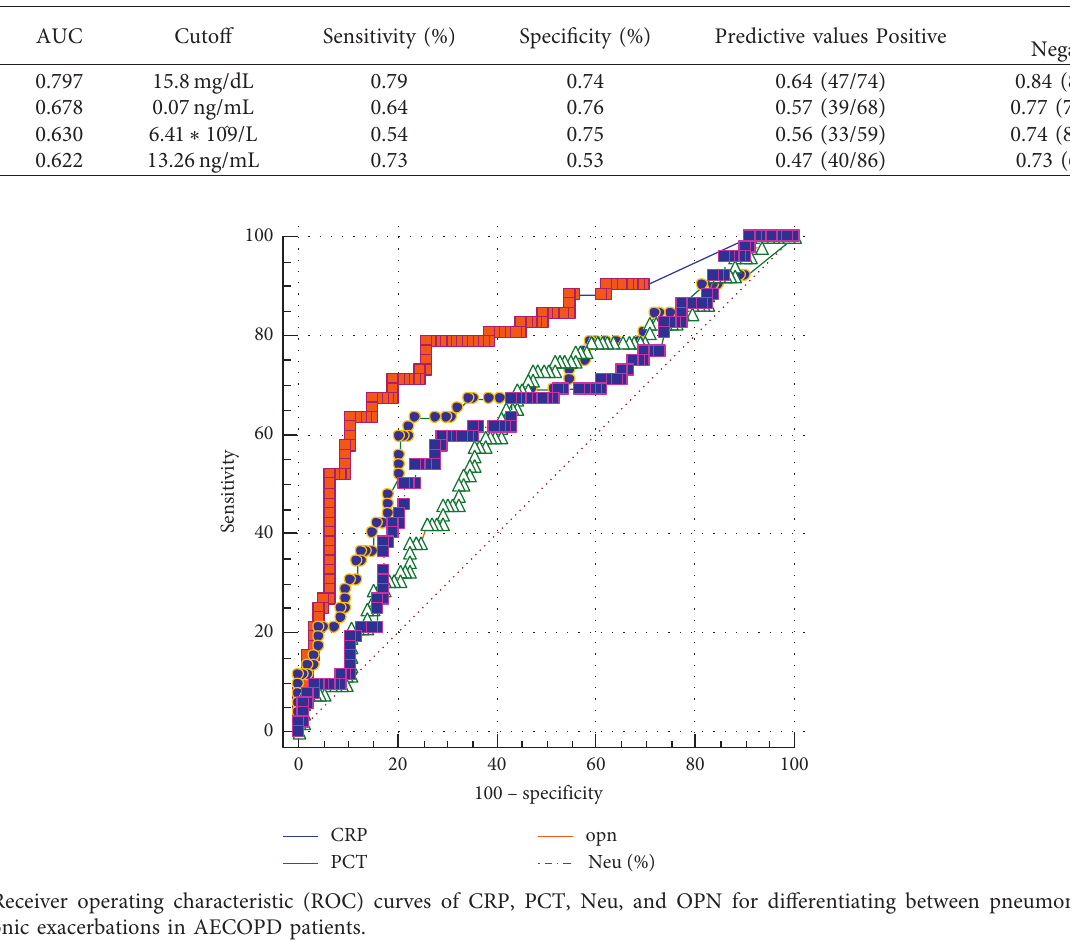
Table 3: The area under the curve, sensitivity, specificity, predictive values, and cutoff values of CRP, PCT, Neu, and OPN.